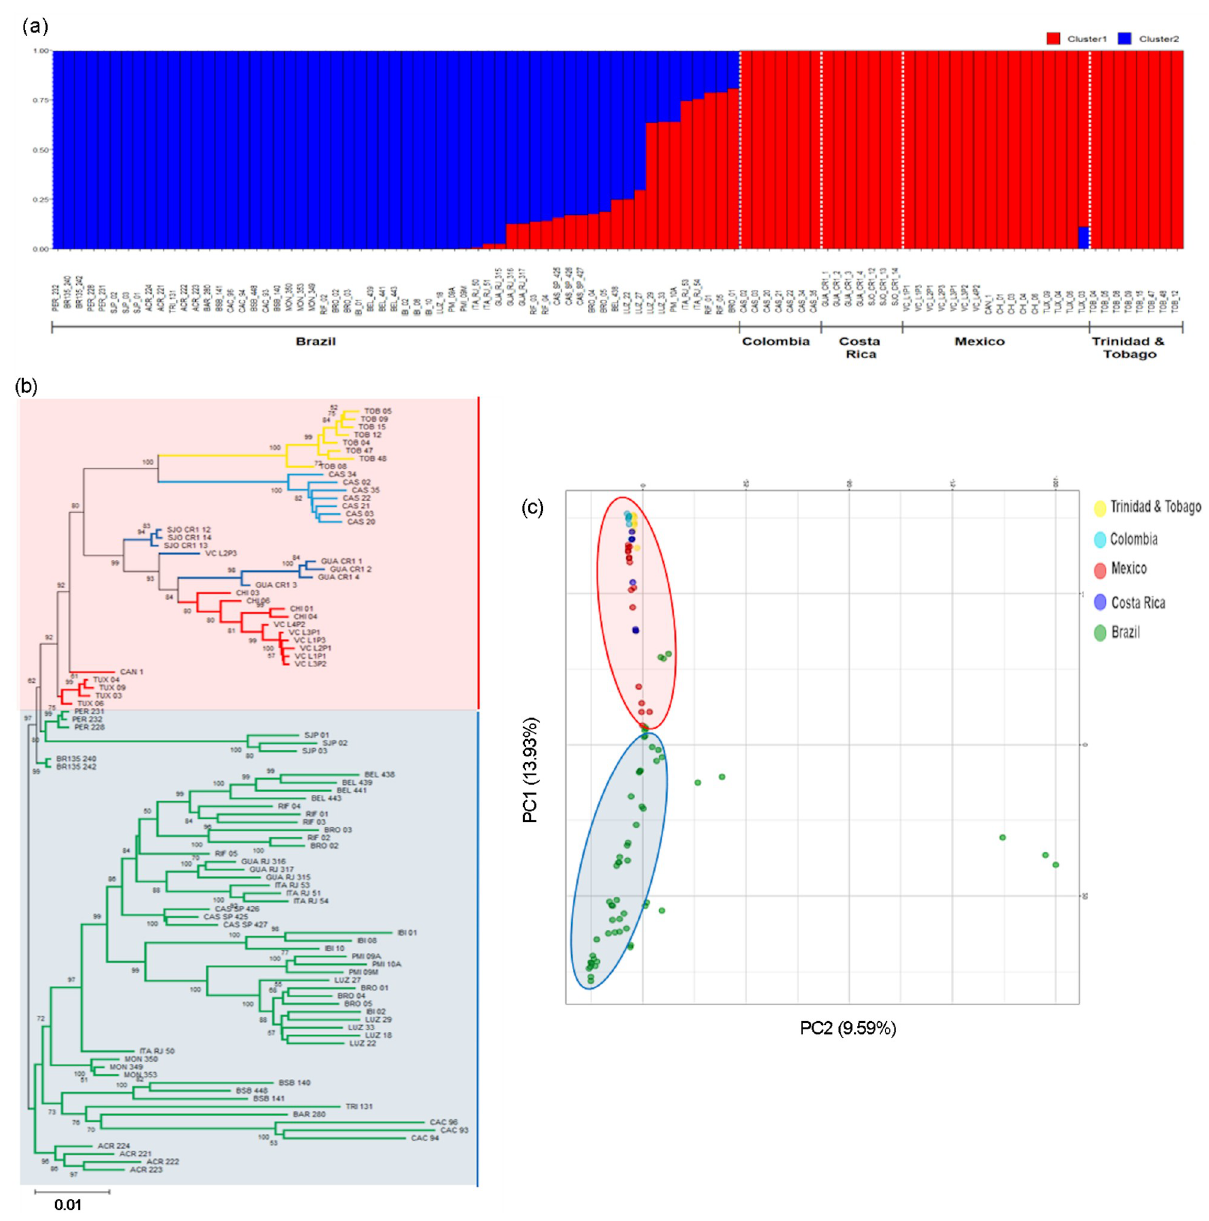
Fig 4. Population genomic structure within A . aculeata , based on 3256 neutral loci SNPs. a) Genomic structure from Bayesian analyses ( K = 2). The y-axis is the population membership, and the x-axis is the sample. Each bar represents an individual and each color is inferred membership in each of the cluster; b) Neighbor-Joining dendrogram based on Nei´s genetic distance. Bootstrap support of nodes is shown. Groups: Northern genetic group (Blue); southern genetic group [41] and c) Scatterplot of the principal components analysis (PCoA) showing the dispersion of samples across the first two principal